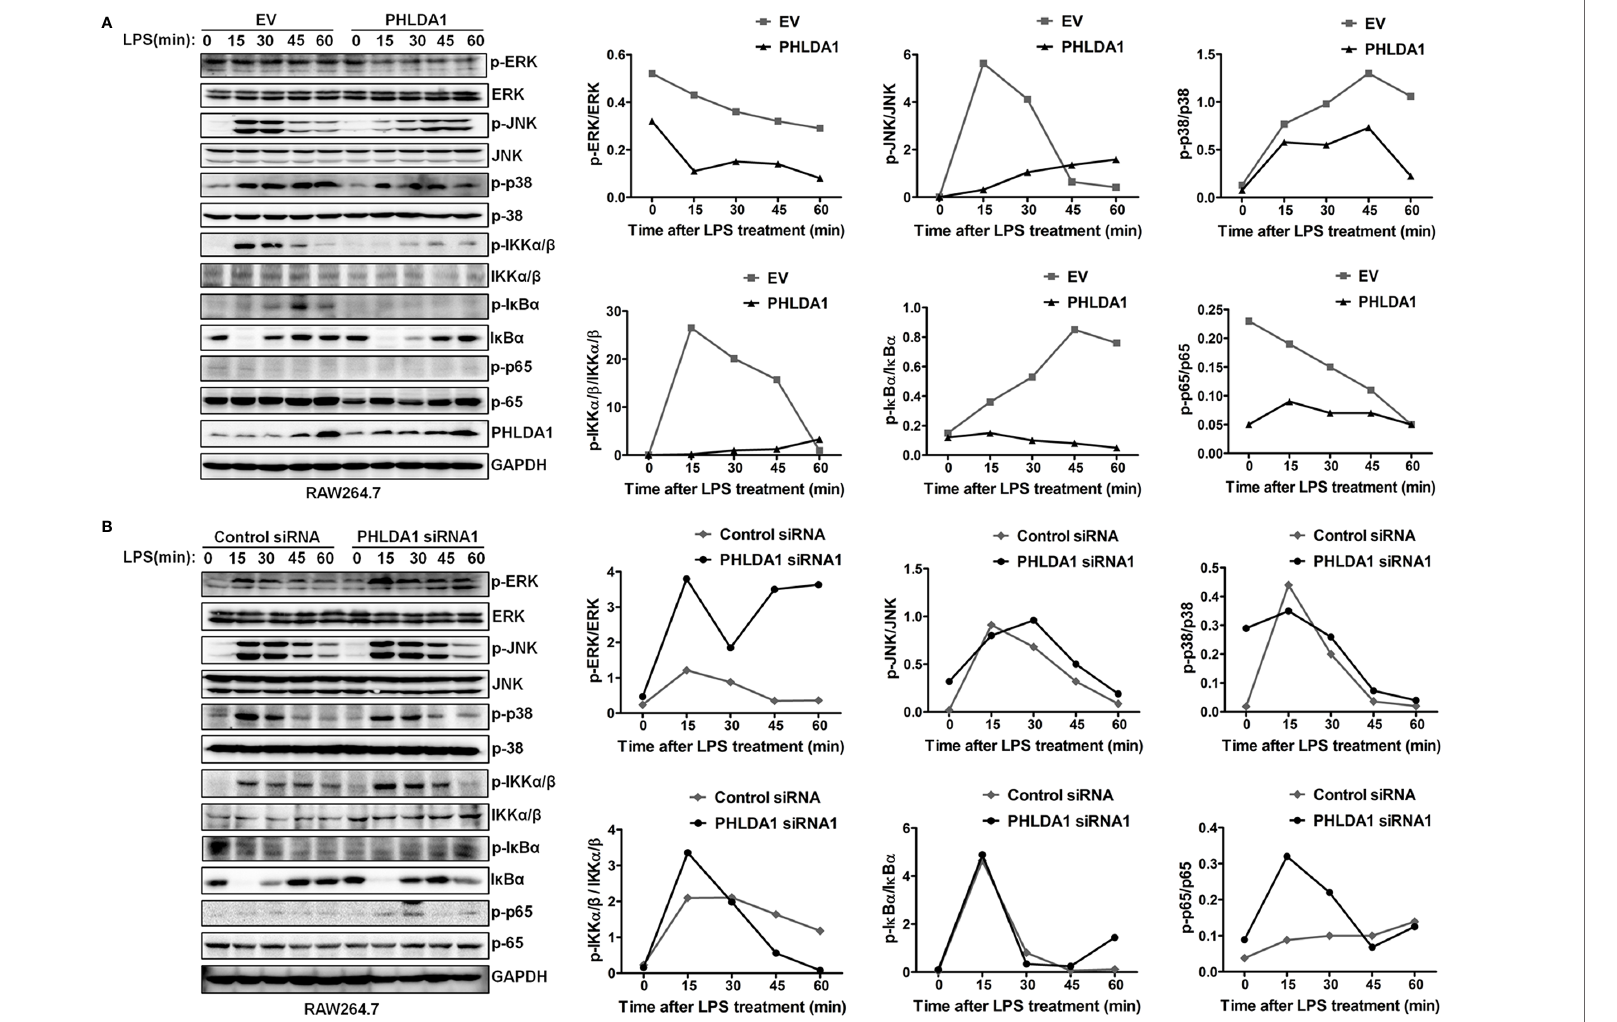
FIGURE 3 | PHLDA1 attenuates the activation of some signal molecules in MyD88-dependent TLR4 signaling pathway. (A) RAW264.7 cells were transfected with EV or PHLDA1 plasmid, and then stimulated with LPS (0.1 m g/ml) for the indicated times. Phosphorylation levels and total protein expressions of important signal molecules (ERK, JNK, p38, IKK a / b , IkBa and p65) in cell lysates were analyzed using Western blot. (B) RAW264.7 cells were transfected with Control siRNA or PHLDA1 siRNA1, and then stimulated with LPS (0.1 m g/ml) for the indicated times. Phosphorylation levels and total protein expressions of the above molecules were analyzed using Western blot. Data shown are presentative of three independent experiments. Phosphorylation levels of the above molecules were quantitated and shown in the right panel. GAPDH was used as a loading